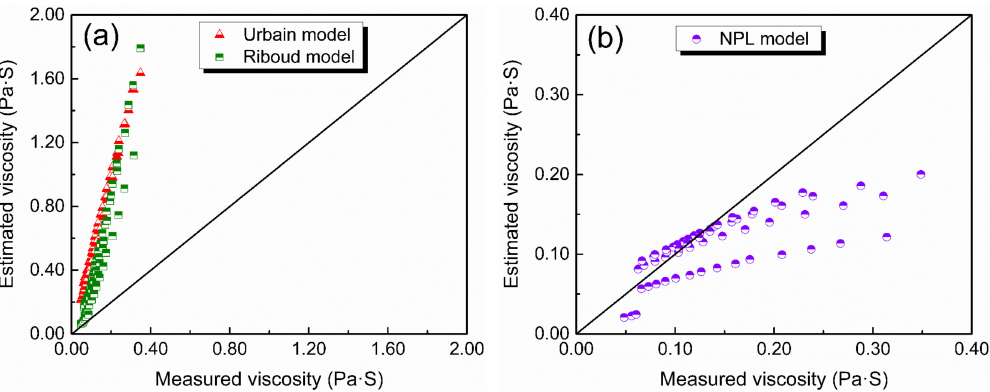
Figure 9. The estimated viscosity against the measured viscosity using different models: ( a ) Urbain and Riboud models, ( b ) NPL